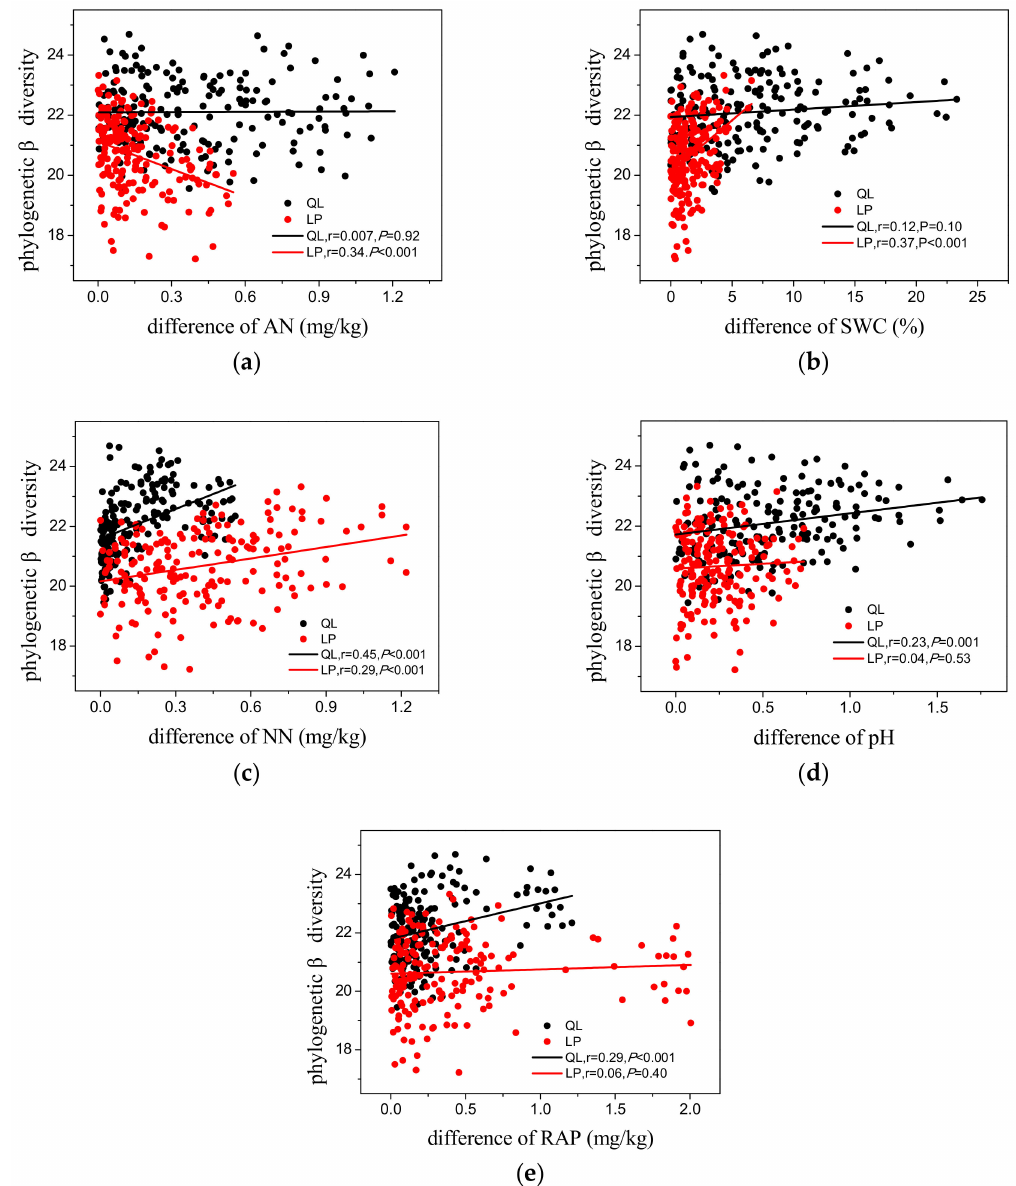
Figure 4. Phylogenetic beta diversity based on ammonia nitrogen (AN) ( a ), soil water content (SWC) ( b ), nitrate nitrogen (NN) ( c ), pH ( d ), rapid available phosphorus (RAP) ( e ). Black dots represent the Qinling Mountains (QL) while red dots represent the Loess Plateau (LP). The black line is the linear regression line of phylogenetic beta diversity in the Qinling Mountains, and the red line is the linear regression line of phylogenetic beta diversity on the Loess